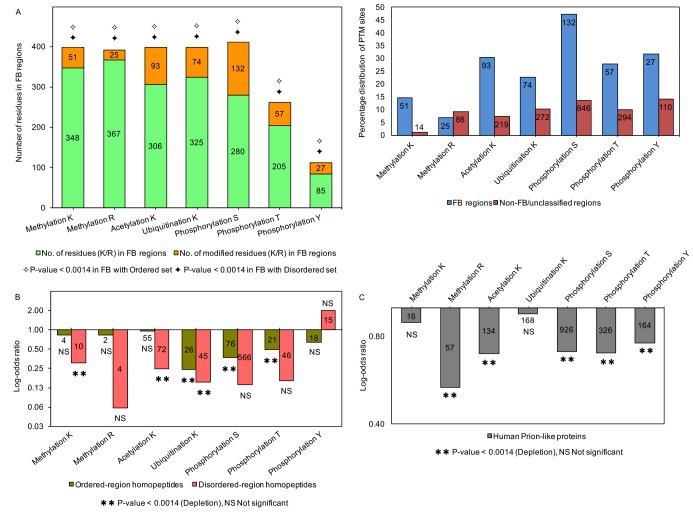
Distribution of PTM sites in ordered and disordered regions of human proteins for various subsets of the data.(A) Distribution of MAU and phosphorylation sites in folding on binding (FB) regions and the percentage distribution of sites in FB non-FB/unclassified regions. Enrichment analysis is performed for the FB set as a sample of total ordered or disordered regions. Due to the limited experimental data, other PTM sites were detected only at very low levels or were not present: nitrosylated cysteines 2 sites, O-linked glycosylation (serine, 1 site and threonine, 5 sites), prenylated cysteine (2 sites), sulfated tyrosine (2 sites) and sumoylated lysines (24 sites), whereas carboxylation, myristoylation, palmitoylation sites are not present in the FB regions. We used hypergeometric probability tests to perform the enrichment/depletion analyses of PTM sites in FB regions. The critical P-value to test the significance is P<0.0014 (to correct for multiple hypotheses). (B) Distribution of MAU and phosphorylation sites in homopeptides. The enrichment and depletion analyses are calculated for homopeptides present in the ordered (olive green) and disordered (peach) regions. The statistical test and critical P-value is as for part (A). (C) Distribution of MAU and phosphorylation sites in Human prion-like proteins (grey). Enrichment analysis is performed for lysines or arginines in the prion-like protein set as a sample of total lysines or arginines in the disordered set, as appropriate. The statistical test and critical P-value is as for part (B).